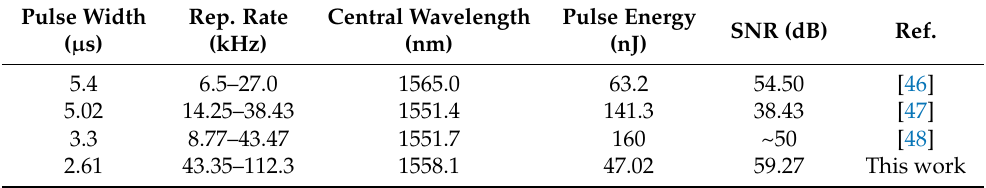
Table 2. Summarization of Q-switched laser parameters for MoS 2 based materials.